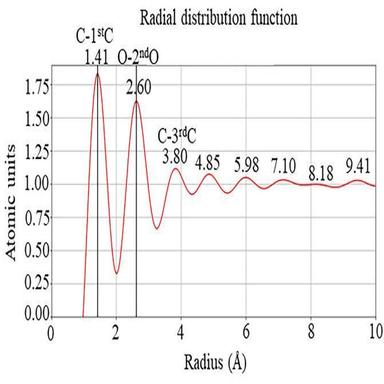
Radial distribution function of the resultant SiOC sample.